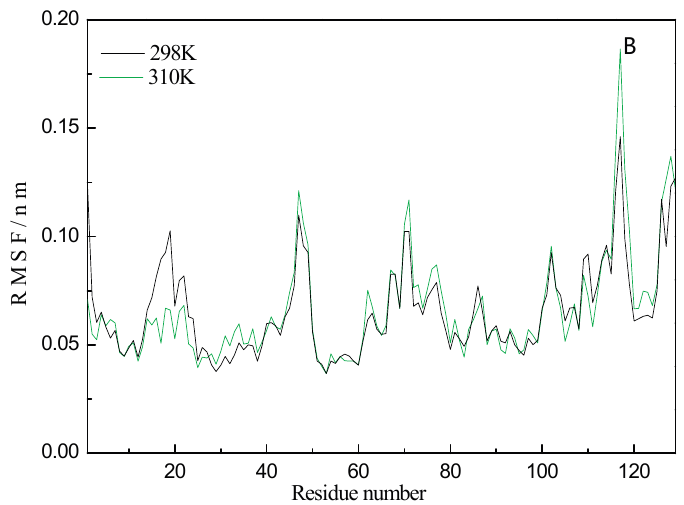
Figure 8. RMSD ( A ) change of receptor LYS backbone at in 2000 ps MD simulation and RMSF ( B ) fluctuation with the residues number for receptor LYS at 298 and 310